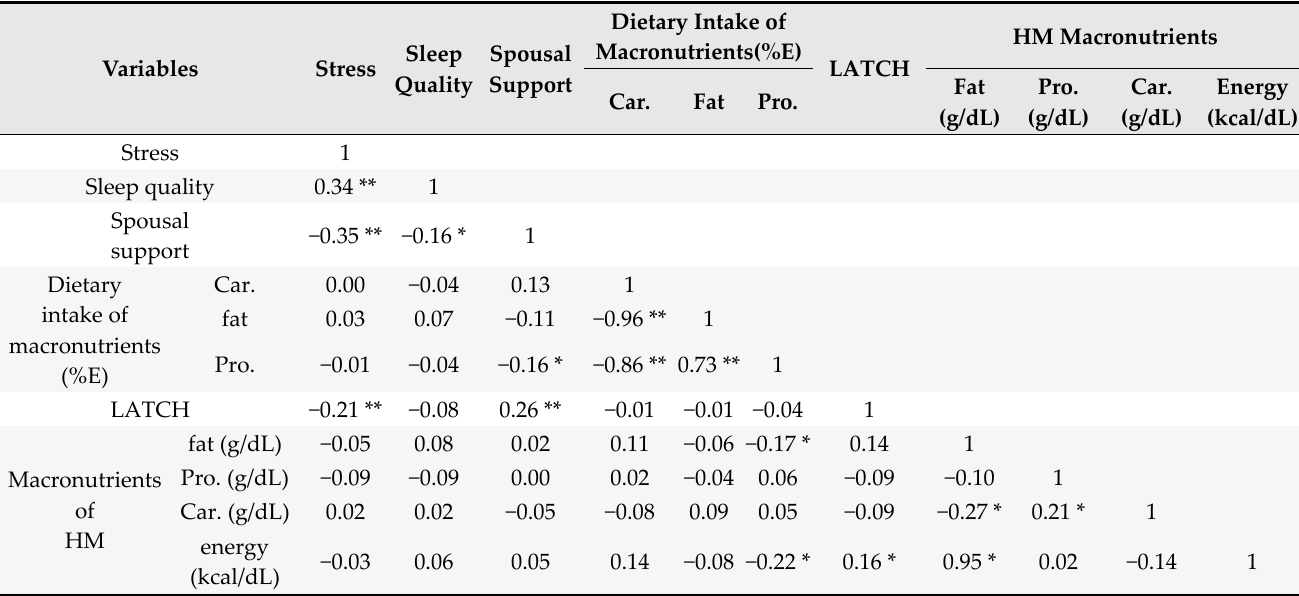
and HM energy (r = − 0.22, p < 0.05). Also, breastfeeding assessment showed a significant positive correlation with HM energy (Table 3). Table 3. Pearson’s correlation analysis of postpartum stress, sleep quality, spousal support, dietary intake of macronutrients, breastfeeding assessment, and HM macronutrients and energy ( n = 159).